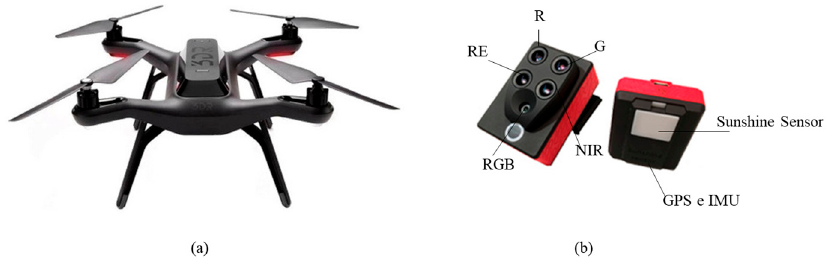
Figure 2. Equipment: ( a ) RPA used for the field survey; ( b ) camera, and sensors of imagery and irradiance. Table 1. Characteristics of the spectral bands used in the study. Band Initial λ (nm) Final λ (nm) Green (G) 530 570 Red (R) 640 Red Edge (RE) Near Infrared (NIR)